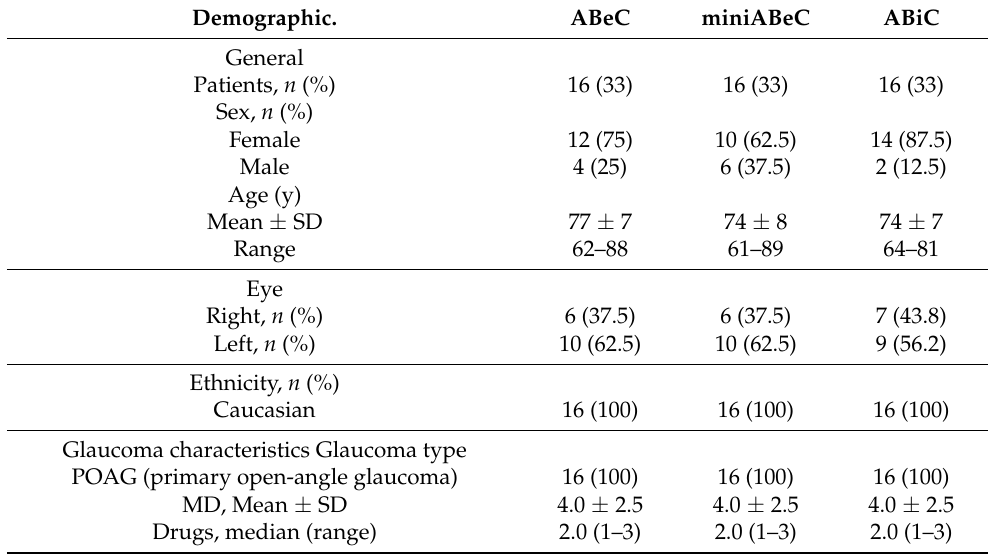
Table 1. Patients’ demographics. Ab externo canaloplasty (ABeC), minicanaloplasty (miniABeC) and ab interno canaloplasty